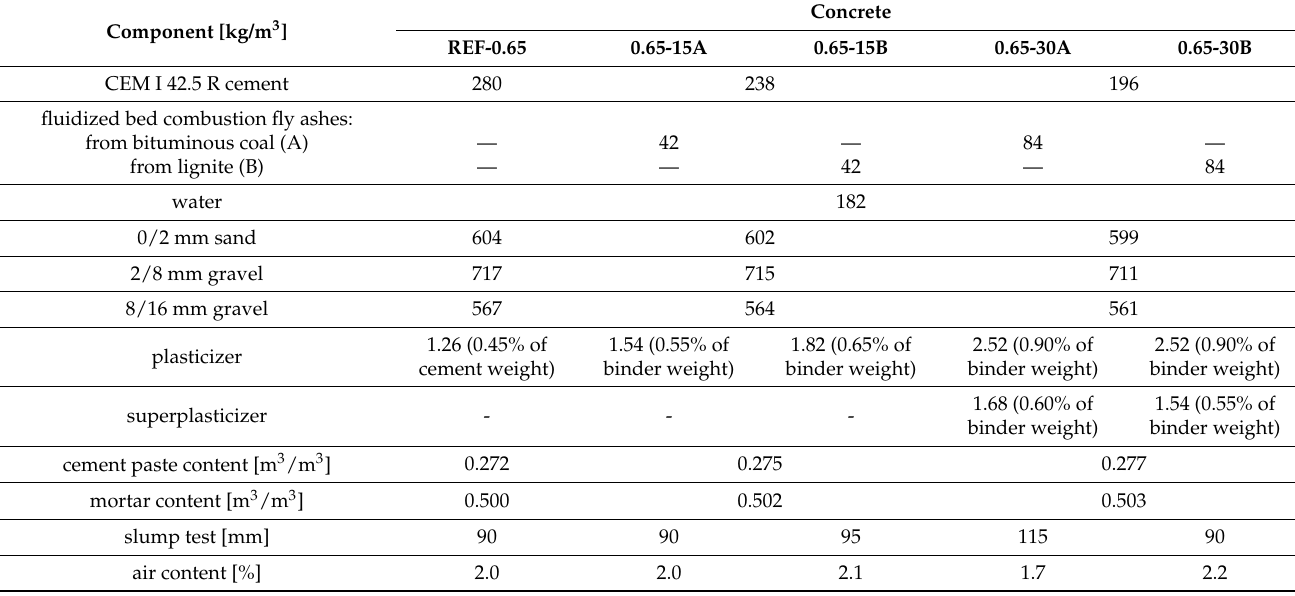
Table 5. Composition of concretes with w / b ratio = 0.65 without and with fluidized bed combustion fly ashes.